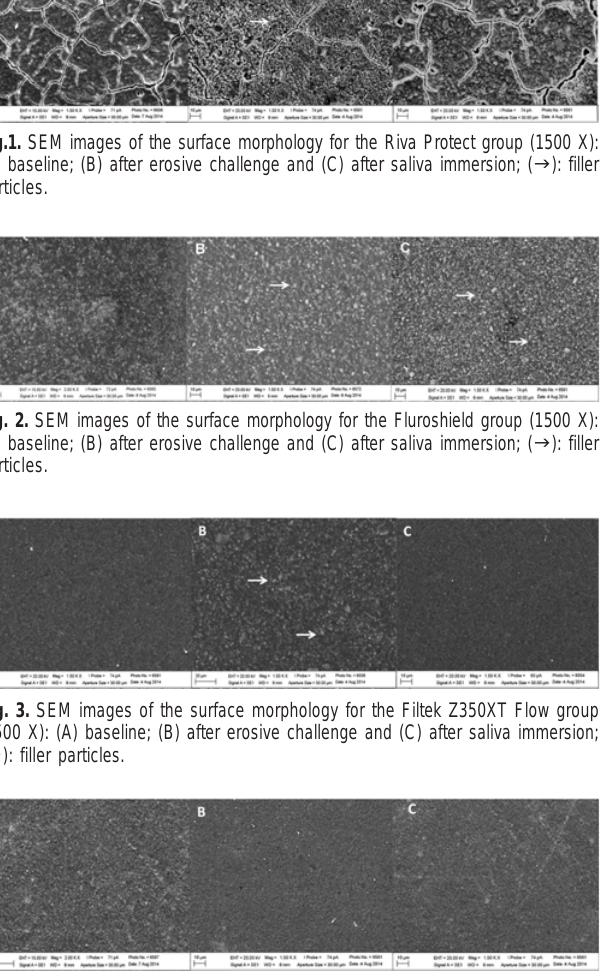
Fig. 4. SEM images of the surface morphology for the Opallis flow group: (A) baseline (2000X); (B) after erosive challenge (1500 X) and (C) after saliva immersion (1500